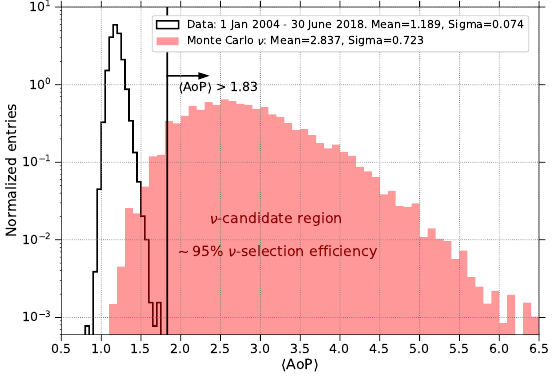
Figure 2. Exposure of the SD of the Pierre Auger Observatory (1 Jan. 2004 - 30 June 2018) as a function of neutrino energy E ν obtained as the sum of the exposures for each neutrino flavor assuming a flavor mixture of ν e : ν µ : ν τ = 1 : 1 :